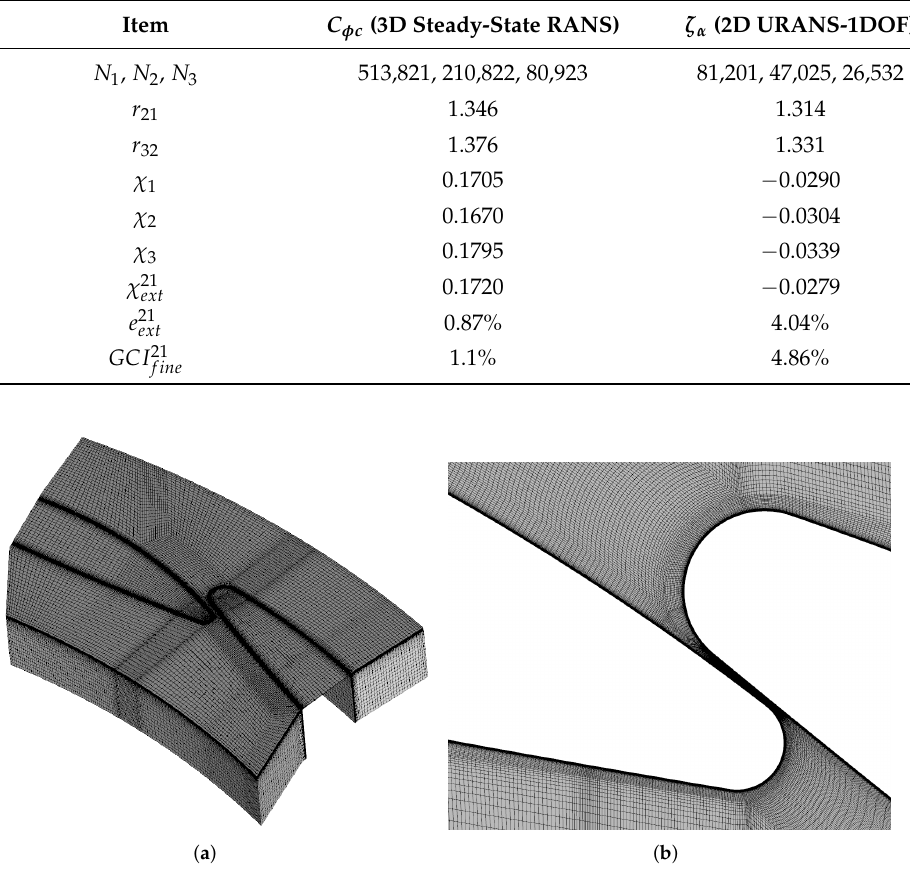
Figure 6. The partial cells of the computational domains: ( a ) the 3D steady-state RANS calculation; ( b ) the 2D URANS-1DOF coupling